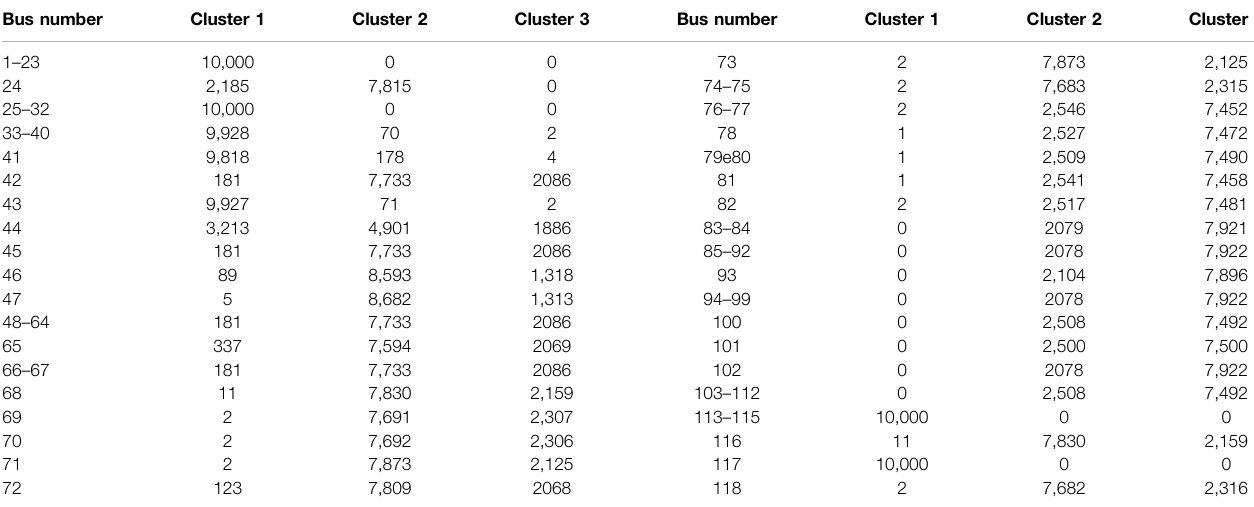
TABLE 4-3 | Simulation results at 80% penetration level. Bus